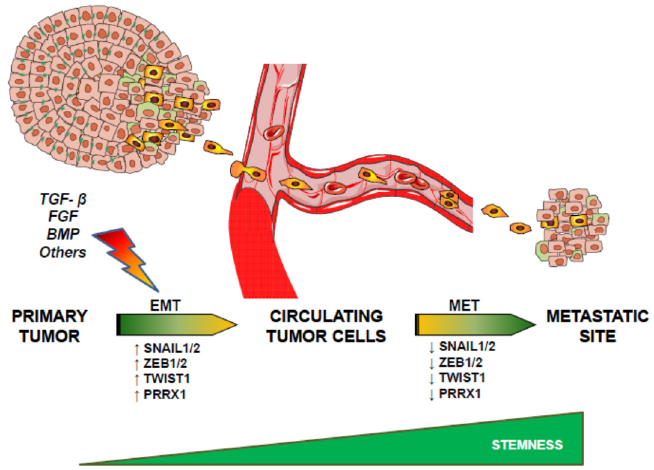
Figure 1. Sequential epithelial-mesenchymal transition (EMT) and mesenchymal-epithelial transition (MET) allows tumor cells to acquire the capacity to migrate and later colonize tissues for an efficient metastatic process. See text for details.